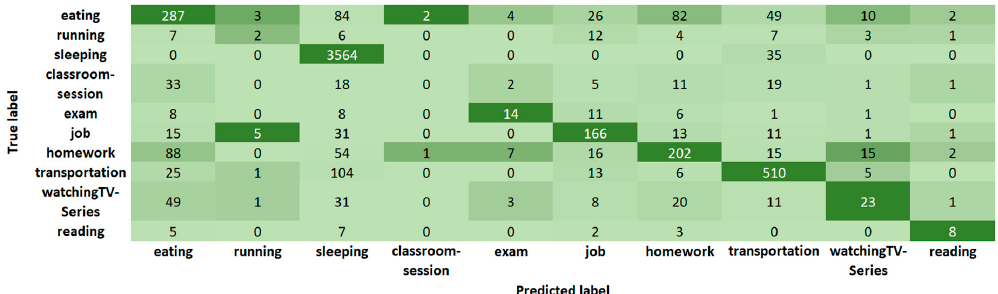
Figure 5. Confusion matrix for daily-activity classification with J48.